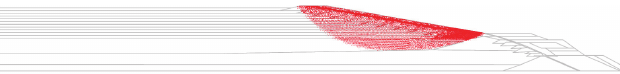
Figure 20: Failure zone of the dam after shaking with extreme